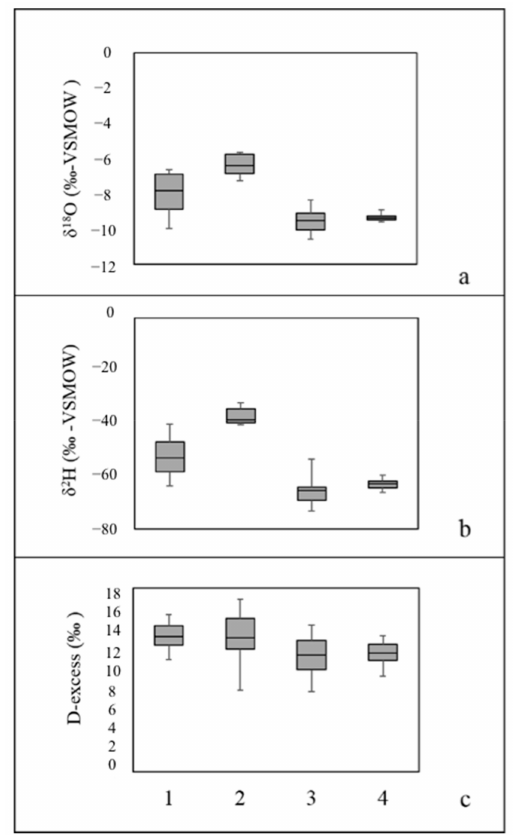
Figure 5. Box plot of ( a ) δ 18 O, ( b ) δ 2 H, and ( c ) d-excess for all the groundwater samples grouped into (1) WSS, (2) WSN, (3) ES, (4) EA low-yield springs (see Figure 2 for the location of the springs). The whiskers represent the 10th and 90th percentiles, the box limits indicate the 25th and 75th percentiles and the line within the box marks is the mean values.